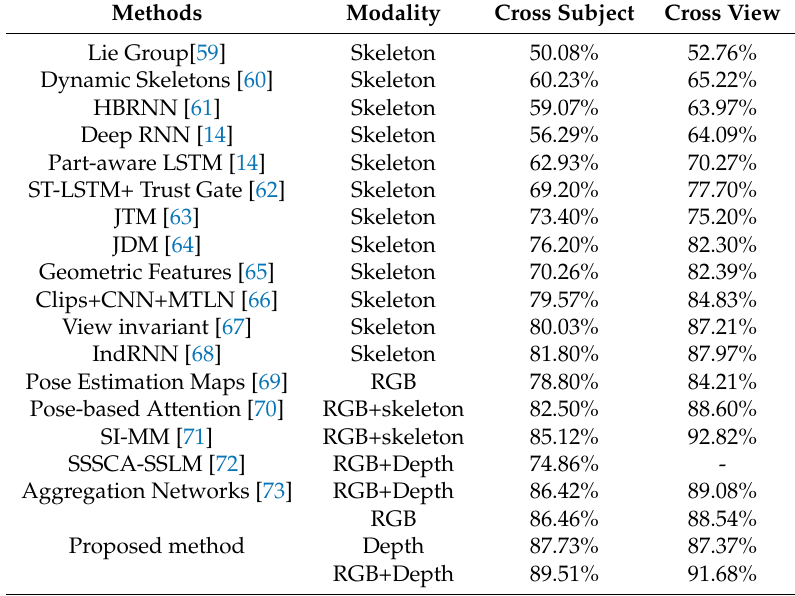
Table 6. Comparison of the proposed method with other methods on the NTU RGB + D dataset. We report the accuracies using both the cross-subject and cross-view